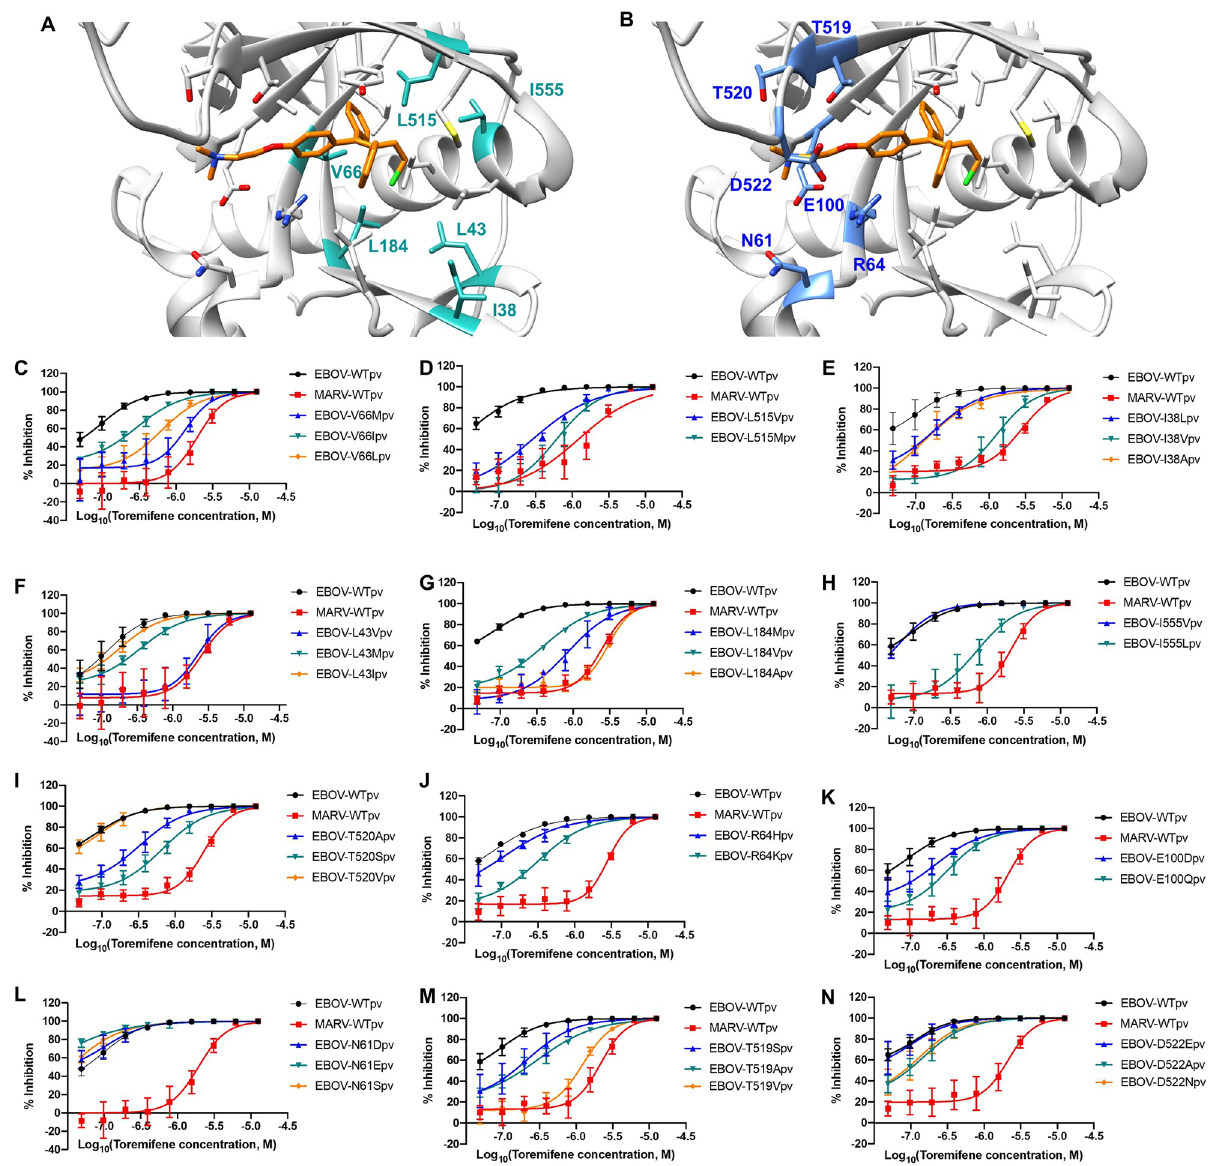
Fig 2. Mutational analysis of EBOV fusion-loop associated cavity reveals additional residues produce a MARV-like dose-response curve for toremifene. Crystal structure of EBOV GP in complex with toremifene highlighting (A) essential residues for binding that produce a MARV-like dose response curve (teal) and (B) residues near the dimethylamine sidechain that play a dispensable role in binding (blue); (C-O) Dose-response curves for mutants at residues V66, L515, I38, L43, L184, I555, T520, R64, E100, N61, T519 and D522 compared to WT EBOV and WT MARV. All error bars represent s.d. from three independent